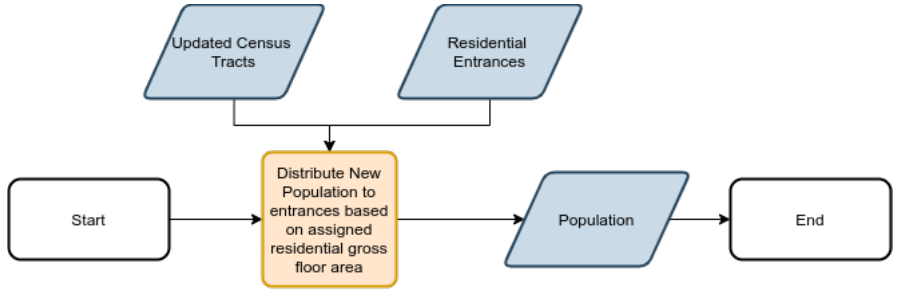
Figure 13. Population distribution.